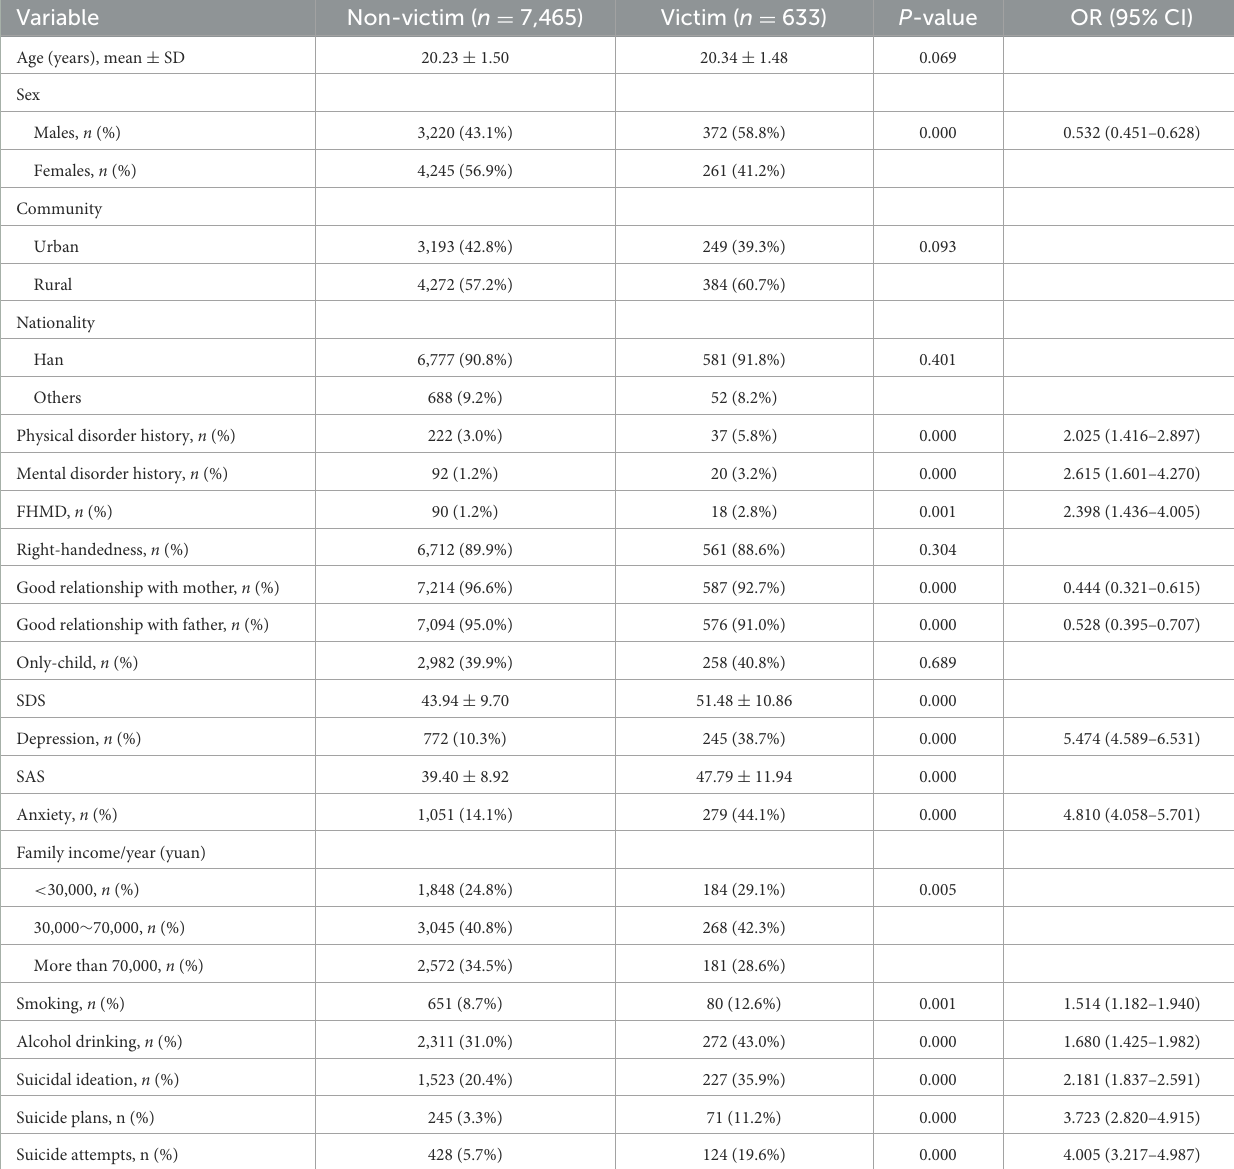
TABLE 1 Comparison of demographics and clinical characteristics between cyberbullying victims and non-victims.